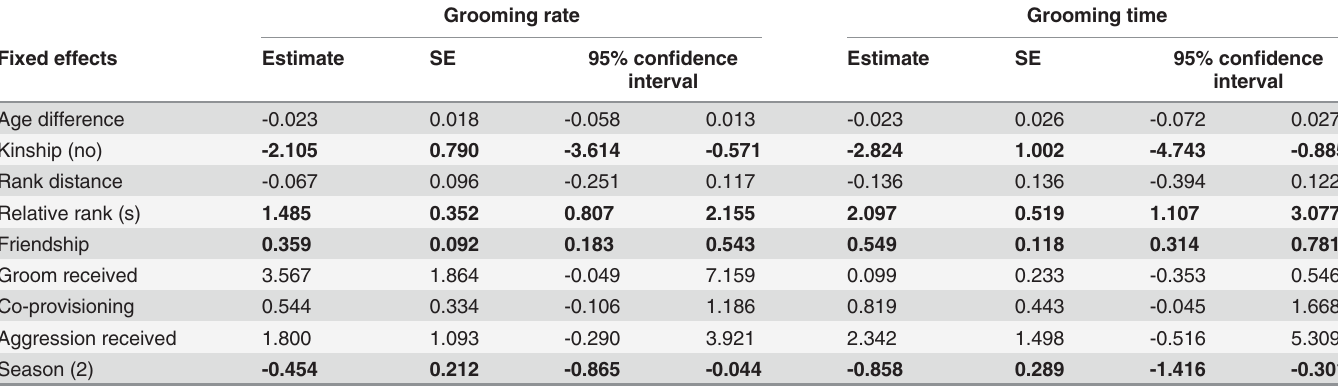
Table 4. Results of LMMs testing grooming rate and grooming time and their relationship to kinship, rank distance, relative rank, friendship, grooming received, co-provisioning, aggression received and season among females with high rank distance. Grooming rate Grooming